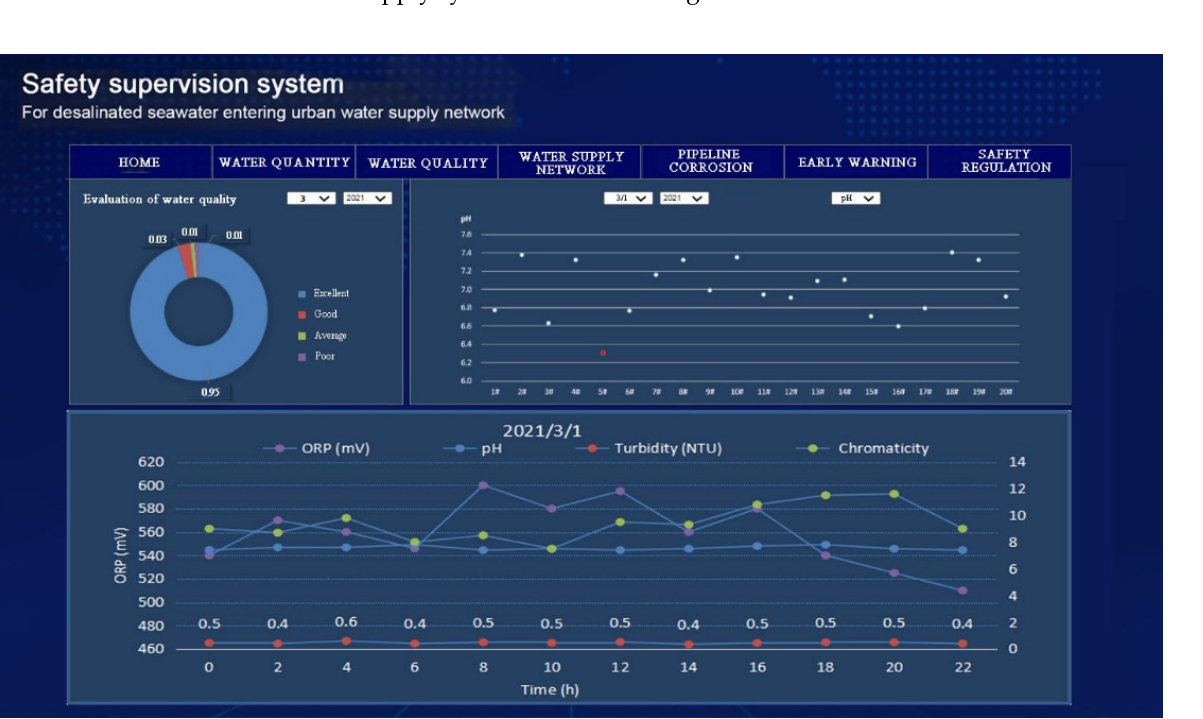
Figure 4. On-line monitoring data of ORP, pH, turbidity, and chromaticity. Table 2. Comparison of measured and standard value of water quality parameters.